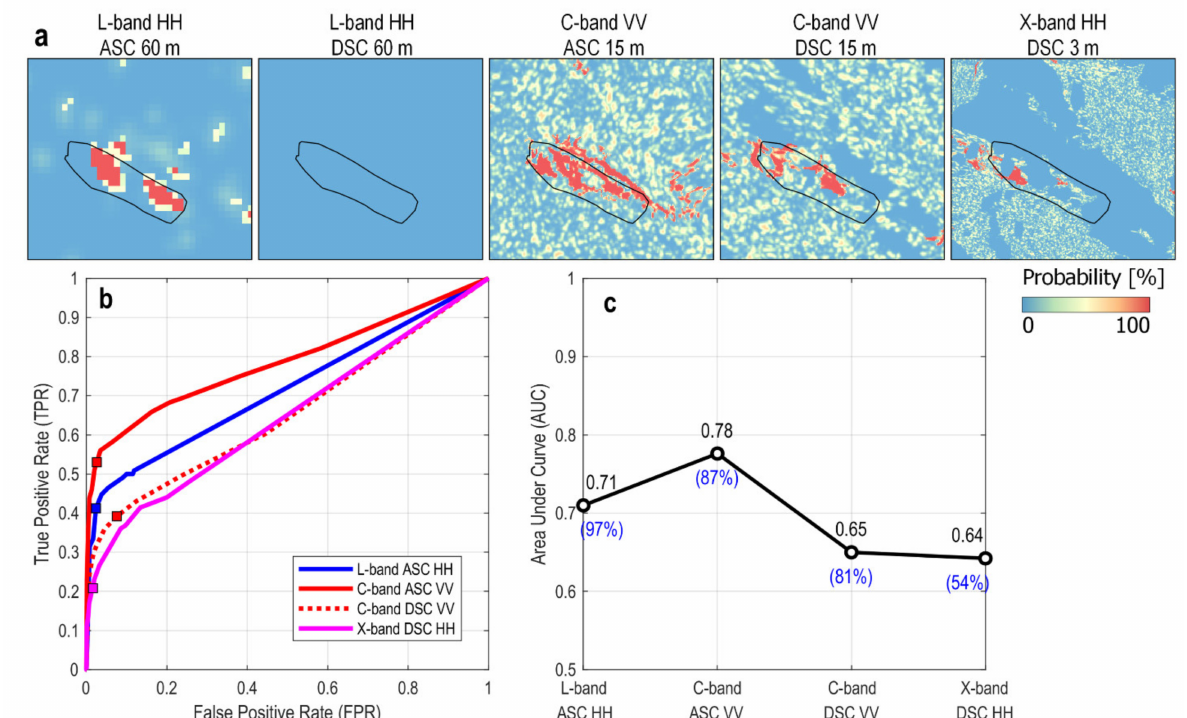
Figure 11. ( a ) Bayesian probability maps obtained from different σ 0 datatypes for the Putanpunas landslide on 7 June 2017. ( b ) ROC curves and ( c ) AUC values for different datatypes. Blue numbers in parentheses are the percentage of effective area within the